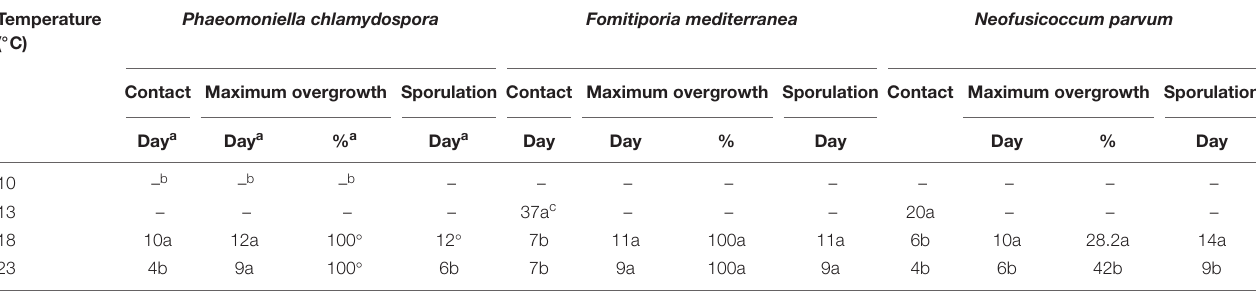
TABLE 2 | In vitro direct activity of the Trichoderma asperellum strain ( Tasp ) on Phaeomoniella chlamydospora , Neofusicoccum parvum , and Fomitiporia mediterranea . Temperature ( ◦